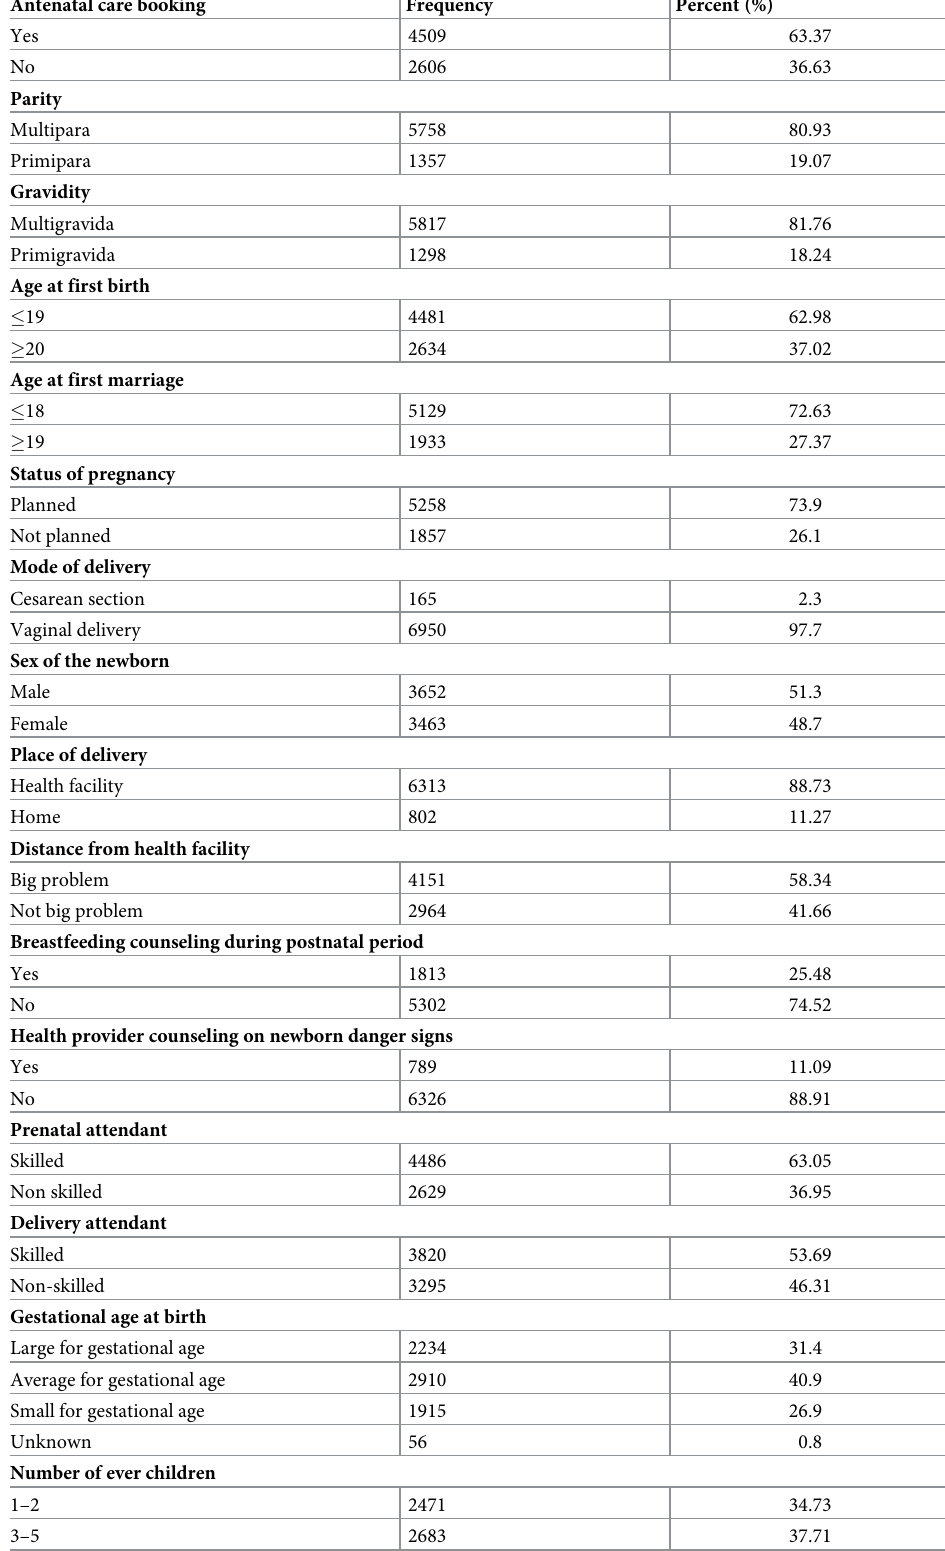
Table 2. Obstetrics, newborn and reproductive health